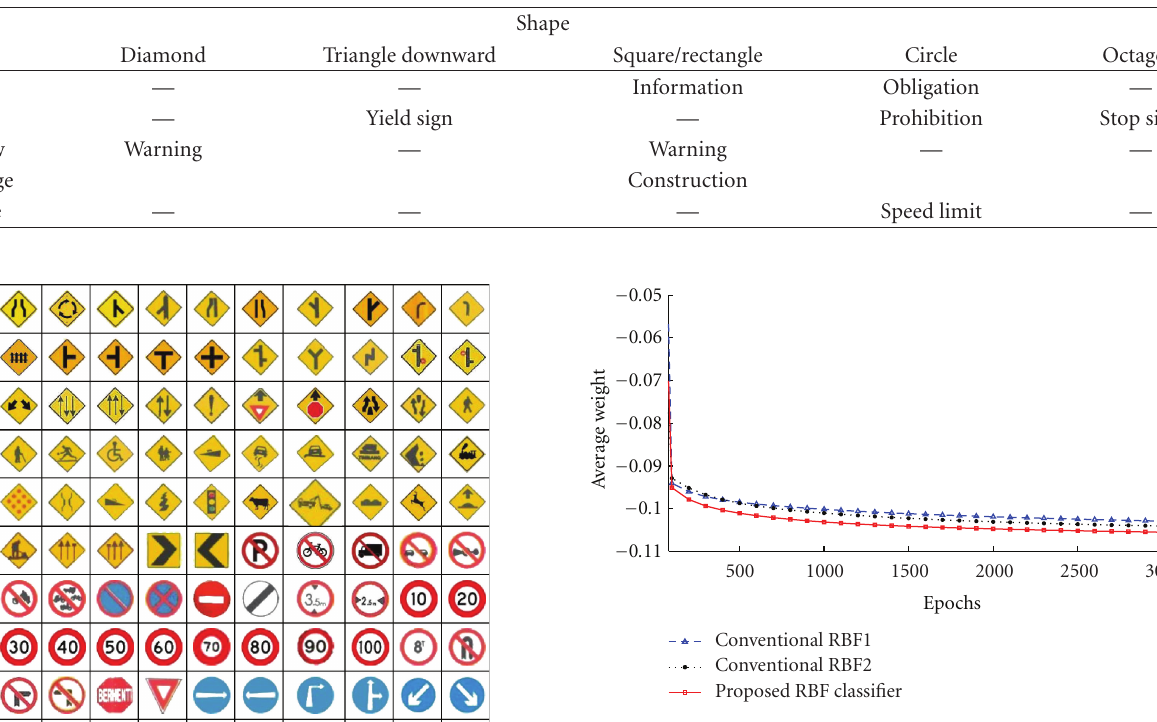
Figure 3: Weight convergence for di ff erent RBF classifiers.